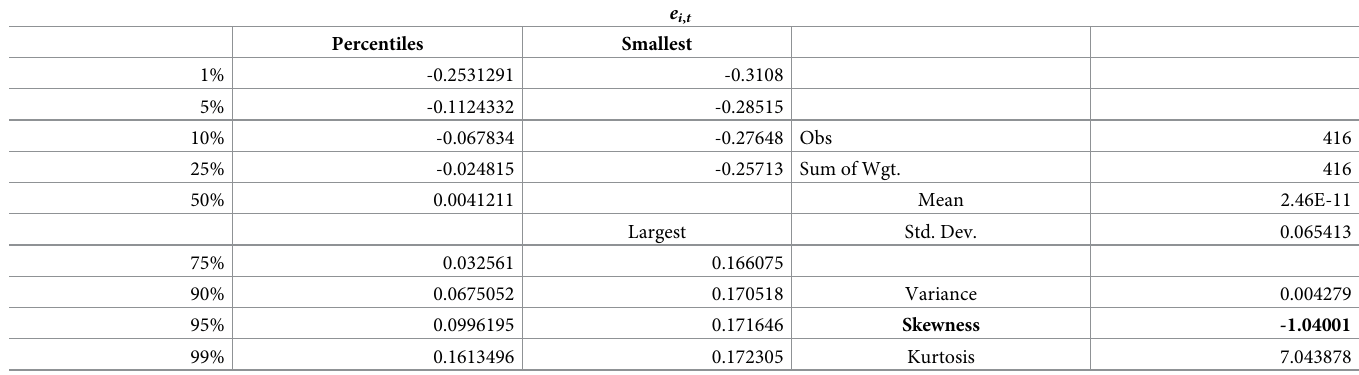
Table 1. Skewness test of the statistical